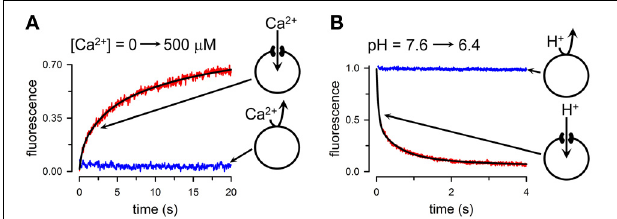
FIGURE 3 | Quantitative transport assays. (A) Rate of Ca 2 + influx into liposomes containing purified Cx26 HCs. Extraliposomal free-[Ca 2 + ] was rapidly increased by mixing in a stop-flow cell from a fewnM to 500 μ M, and the rate of increase in emission from Fluo-5N trapped into the liposomes was followed. Red record: liposomes containing Ca 2 + -permeable Cx26 HCs; blue record: liposomes without HCs. The black line is a multi-exponential fit to the data used to calculate the rate of Ca 2 + influx. (B) Changes in intraliposomal pH followed by the pH-sensitive probe fluorescein attached to a phospholipid head group. Extraliposomal pH was rapidly reduced from 7.6 to 6.4 by mixing in a stop-flow cell, and the rate of decrease in pH was followed by the quenching of the fluorescein bound to the inner leaflet of the liposomes bilayer. The black line is a multi-exponential fit to the data used to calculate the rate of liposome acidification. Modified from Fiori et al.,